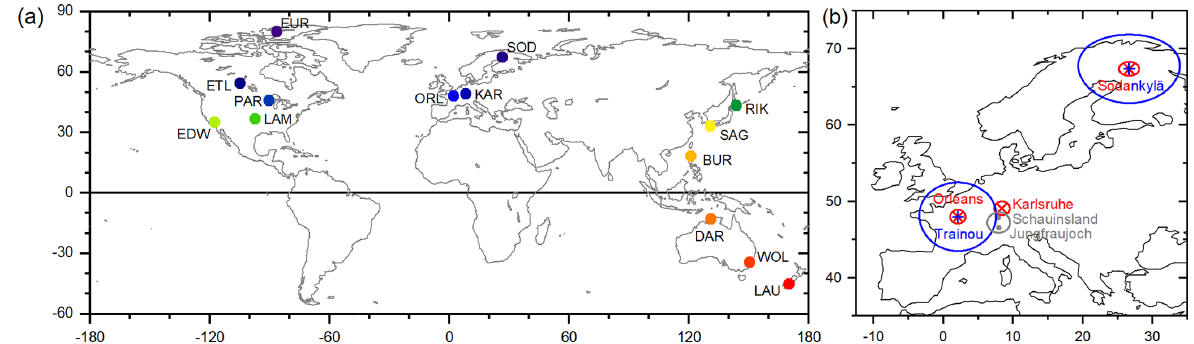
Figure 8. Maps showing the location of the reference measurements used for the validation. (a) Global map with the 14 TCCON stations (more detailed information on these sites is given in Table 1). (b) Map indicating the areas accepted for valid horizontal collocations in the surroundings of the European reference stations: TCCON sites and the 100km collocation radius (red crosses and circles), AirCore sites and the spatial collocation circles with 500km radius (blue stars and circles), and GAW sites and the collocation circle with 150km radius (grey dots and circle). Table 1. Locations of TCCON sites, amount of the satellite data compared to TCCON, and references. “Number” gives the total number of single satellite footprint collocations and “Days” the number of days with